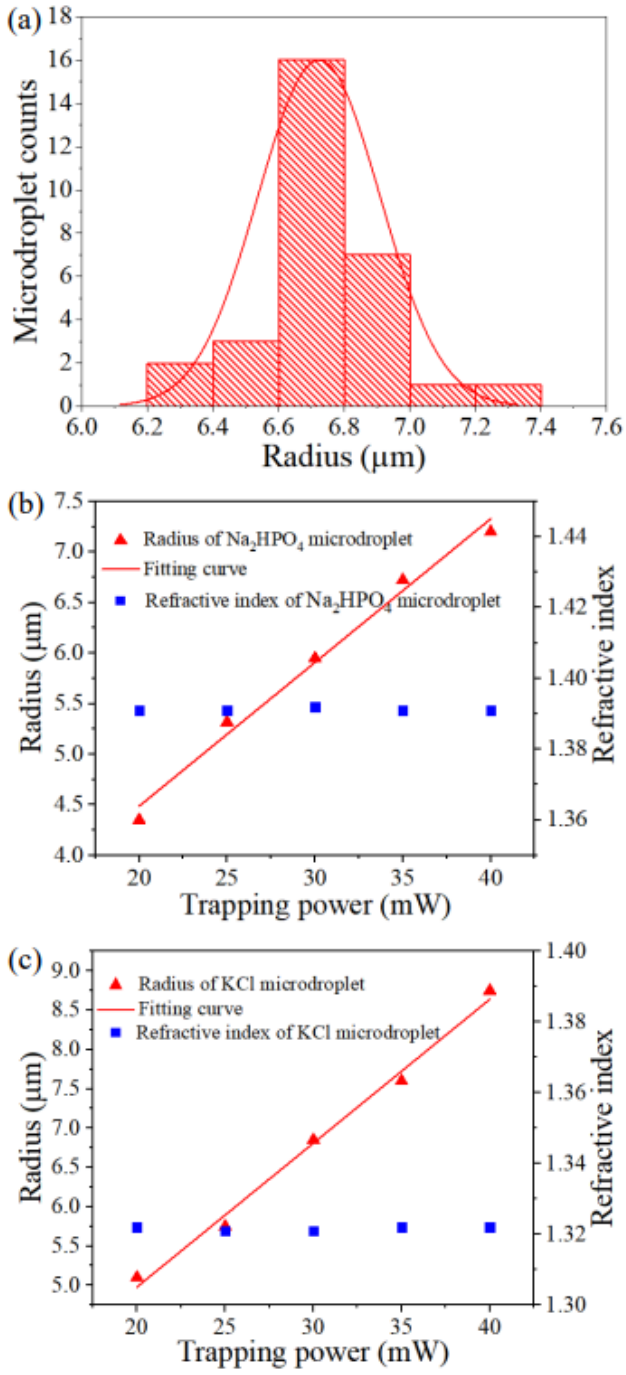
Figure 4. ( a ) Histogram of the radius of the Na 2 HPO 4 microdroplet. ( b ) The Na 2 HPO 4 microdroplet and ( c ) The KCl microdroplet radius and refractive index as a function of the trapping power obtained using the same method of the radius histogram in ( a ). The solid line denotes the linear fitting curve.